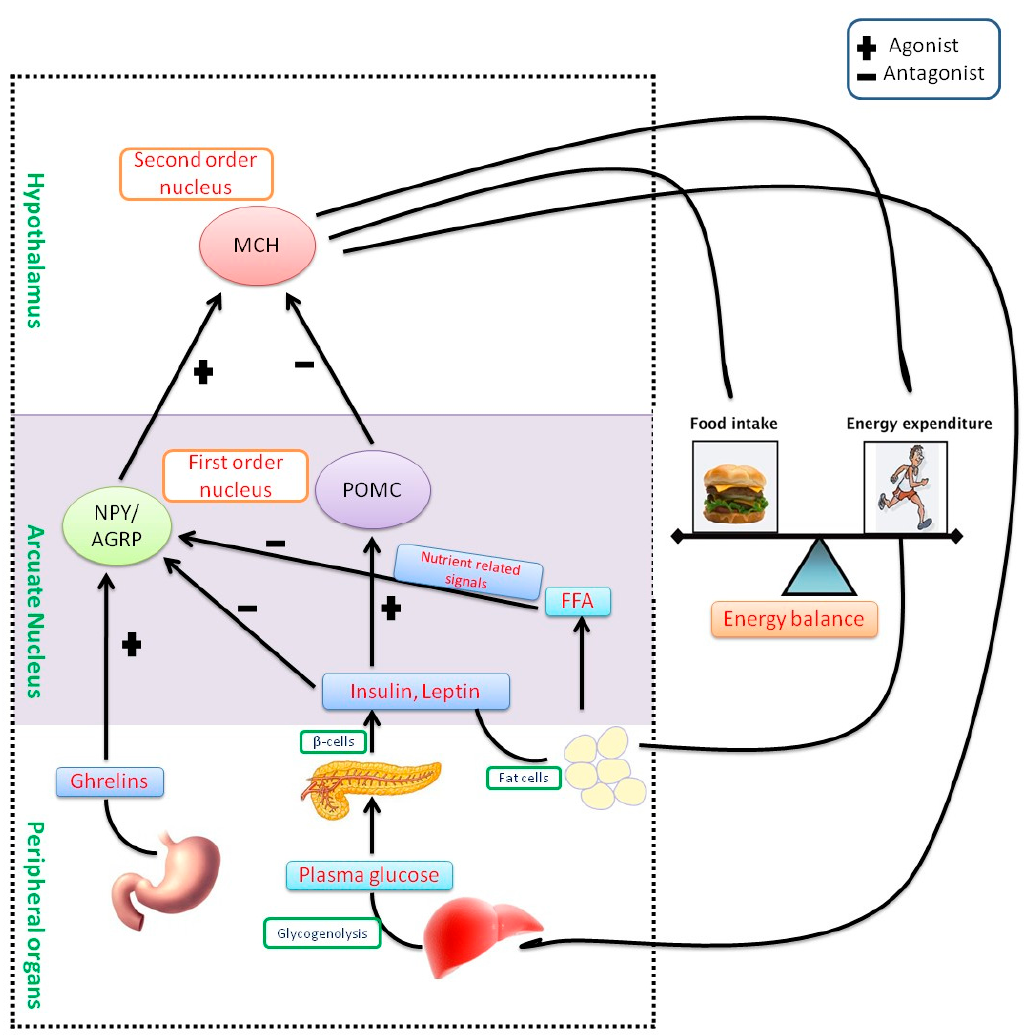
Figure 1. Pathophysiology of obesity and energy homeostasis—Melanin-concentrating hormone (MCH) is a peptide hormone, synthesized by the neurons of the hypothalamus, which normally stimulate food intake. These neurons are arbitrated by POMC as well as NPY/AGRP in an arcuate nucleus. Leptin and insulin are peptide hormones that activate POMC while inhibiting NPY/AGRP, consequently reduces body weight through energy expenditure or lipolysis and release free fatty acids (FFA). In contrast, the hunger hormone, ghrelin provokes NPY/AGRP and enhances body weight through the intake of food. MCH neurons are impeded by POMC cells, however, NPY/AGRP neurons are known to have an antagonist effect. Weight loss reduces insulin and leptin amounts in the blood while increasing ghrelin levels. This response is regulated by the arcuate nucleus (triggering of NPY/AGRP and impeding of POMC) that ultimately activates MCH neurons.